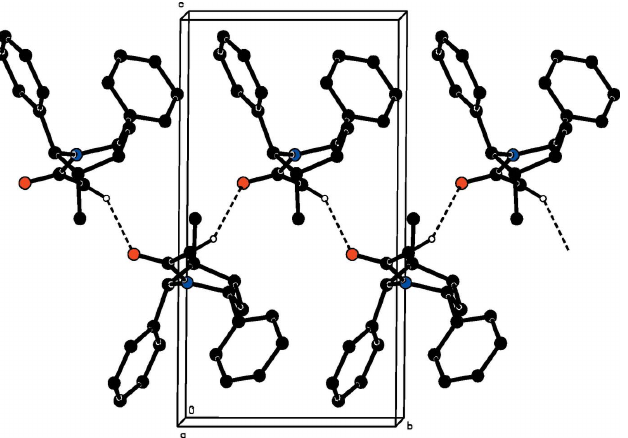
Figure 2 A partial view along the b axis of the crystal packing of the title compound, showing the formation of a molecular chain by C—H (cid:3)(cid:3)(cid:3) O interactions (dotted lines).